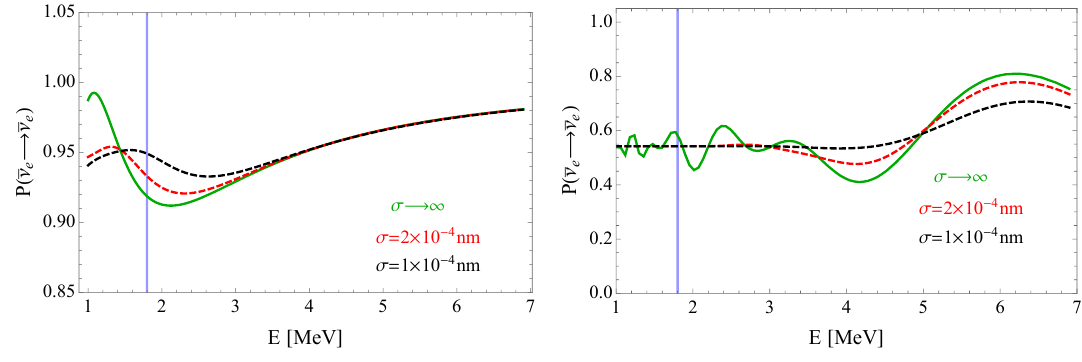
Figure 1 . Left: the electron antineutrino oscillation probability as a function of the neutrino energy for L = 1 km, representative of short-baseline experiments like RENO and Daya Bay. Right: the average electron antineutrino oscillation probability at KamLAND. In both panels, the colors correspond to different values of the decoherence parameter σ . The light blue, vertical line sets the threshold for inverse beta-decay detection. All other oscillation parameters are fixed at their current best-fit values, see [21], and we assume that the mass ordering is